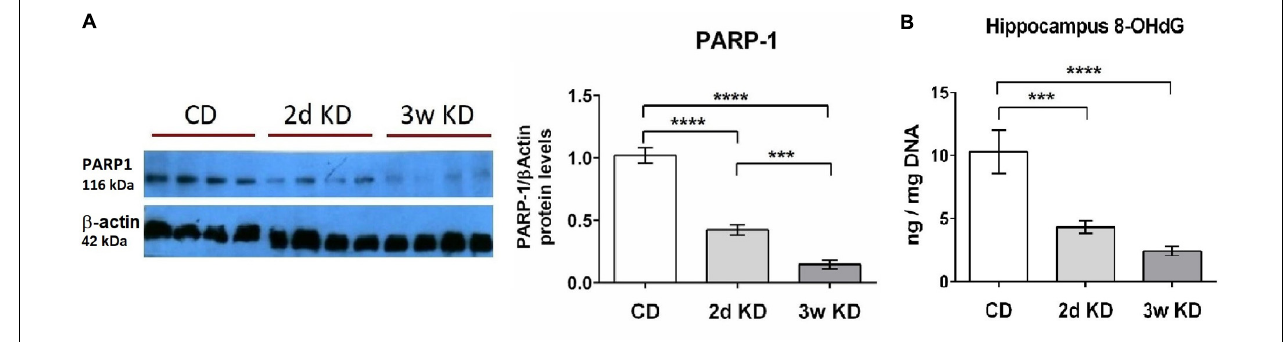
FIGURE 2 | Effect of KD treatment on hippocampal PARP-1 levels and 8-OHdG levels. (A) Quantification of normalized PARP-1 protein levels in hippocampi obtained from animals fed standard chow (CD), or KD for 2d or 3w. Representative image of PARP-1 Western blot included. Each lane represents an individual animal. Blots were repeated 2–3 times. (B) Significant and progressive decrease in 8-OHdG levels was observed in hippocampi obtained from KD treated animals. CD, n = 6; 2d KD, n = 8; 3w KD, n = 8 ( n = 2 for each animal).